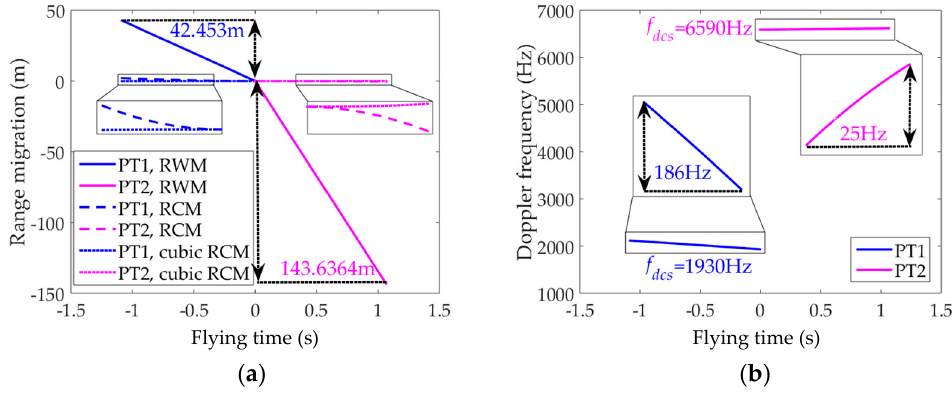
Figure 3. Simulated results for range migration and Doppler frequency migration: ( a ) Range walk migration ; ( b ) Range curvature migration; ( c ) Cubic RCM; and ( d ) Doppler centre shift and Doppler bandwidth.